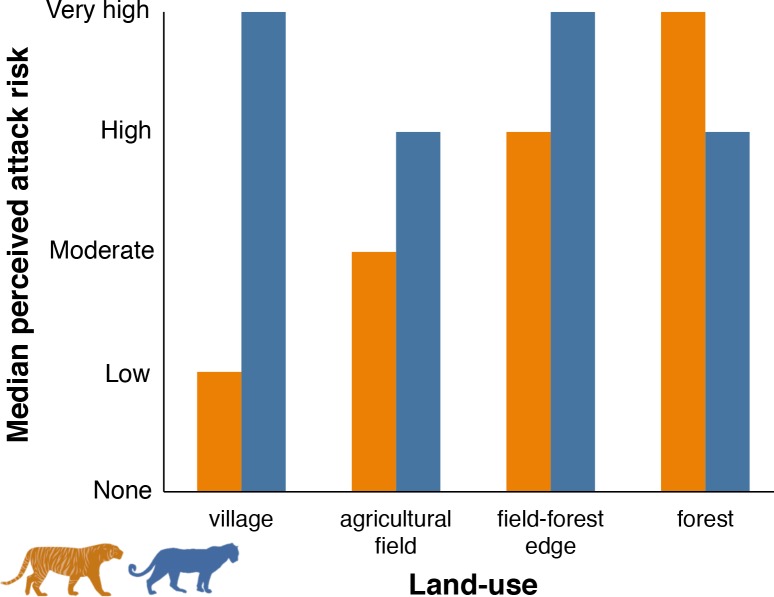
Livestock owners median perceived attack risk from tigers and leopards in different land-use categories.Tiger risk is shown in orange; leopard risk is shown in blue. Sample size: nvillage-tiger = 19; nvillage-leopard = 44; nfield-tiger = 39; nfield-leopard = 50; nedge-tiger = 51; nedge-leopard = 40; nforest-tiger = 95; nforest-leopard = 60.